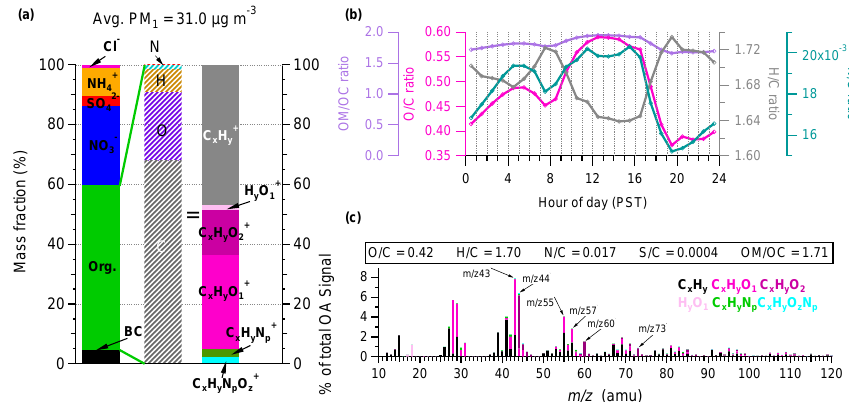
Figure 5. (a) Overview of the average PM 1 and OA compositions in Fresno 2013; (b) average diurnal profiles of the oxygen-to-carbon (O / C), hydrogen-to-carbon (H / C), nitrogen-to-carbon (N / C), and organic-matter-to-organic-carbon (OM / OC) ratios of OA, where the O / C, H / C and OM / OC elemental ratios were determined using the improved-ambient method (Canagaratna et al., 2015); and (c) average high-resolution mass spectrum of OA colored by ion families. The average elemental ratios for the organic aerosol fraction are detailed in the